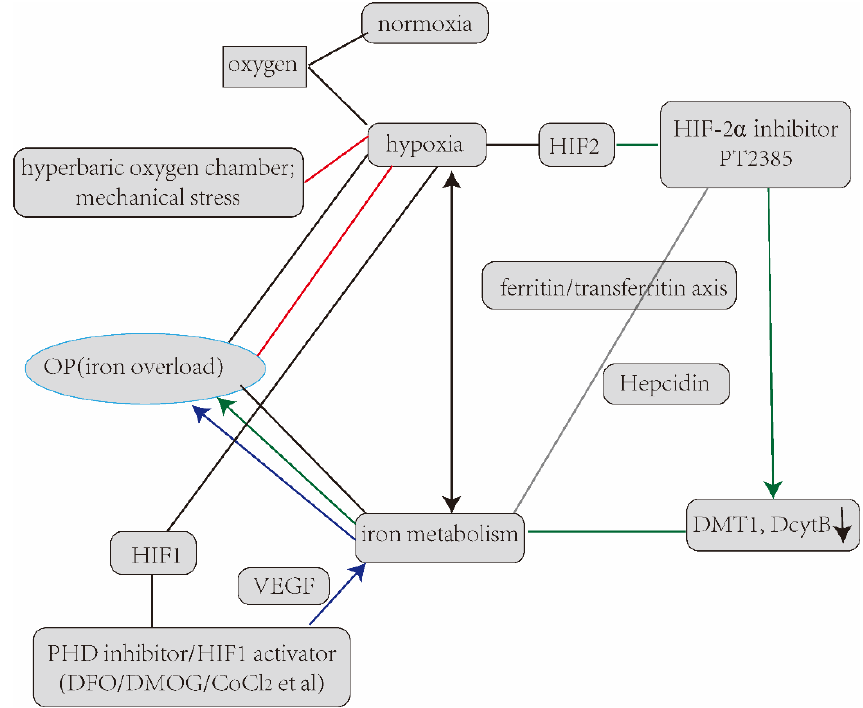
Figure 5. The summary of articles and prospects for hypoxia in OP.